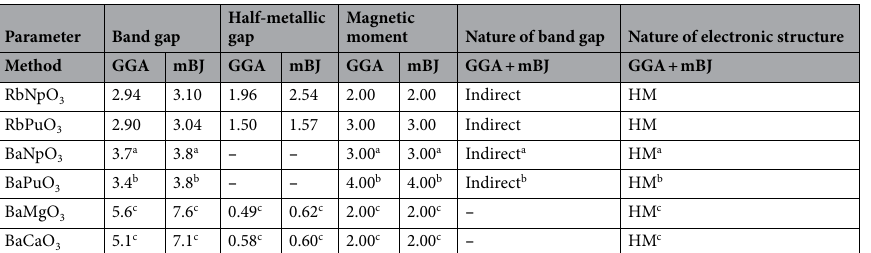
Table 2. Illustrated values of indirect band gap (eV) and half-metallic gap (eV), magnetic moment (µ B ), determined via GGA and GGA + mBJ approximations for RbMO 3 perovskites. [a] 24 , [b] 25 , [c] 13 . The findings of other perovskites 13,24,25 are listed for